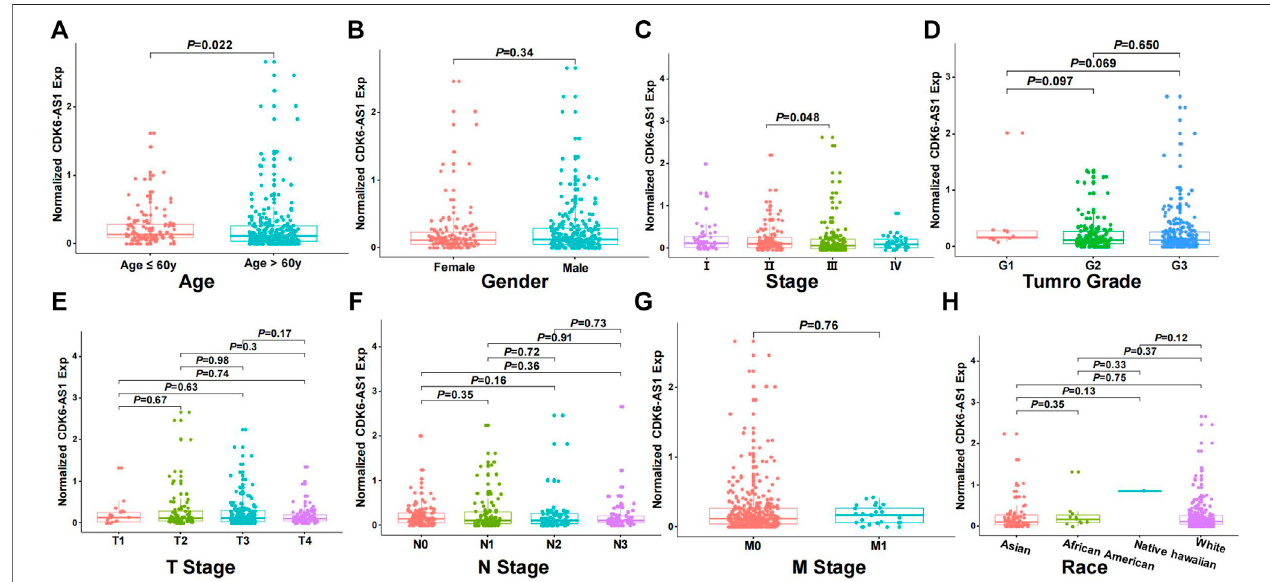
FIGURE 2 | The relationship between CDK6-AS1 expression and clinical features. (A – H) The expression of CDK6-AS1 among patients with age ≥ 60 years and < 60 years, male and female, I – IV clinical stages, G 1 – 3 grades, T 1 – 4 stages, N 0 – 3 stages, M 0 – 1 stages, and different races.